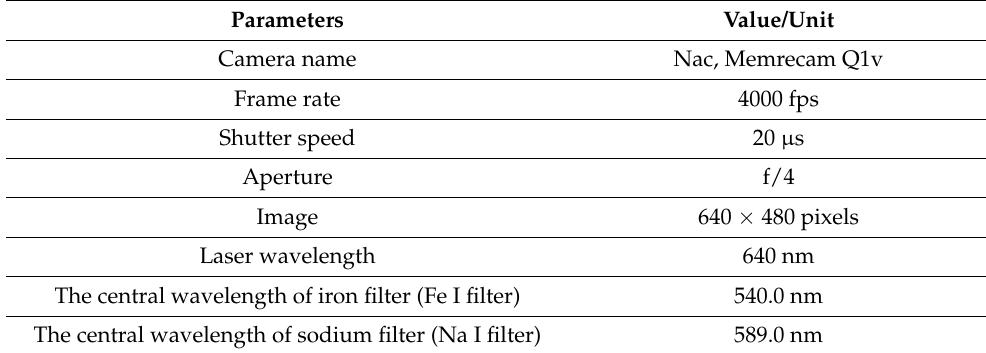
Table 5. Summary of laser observation